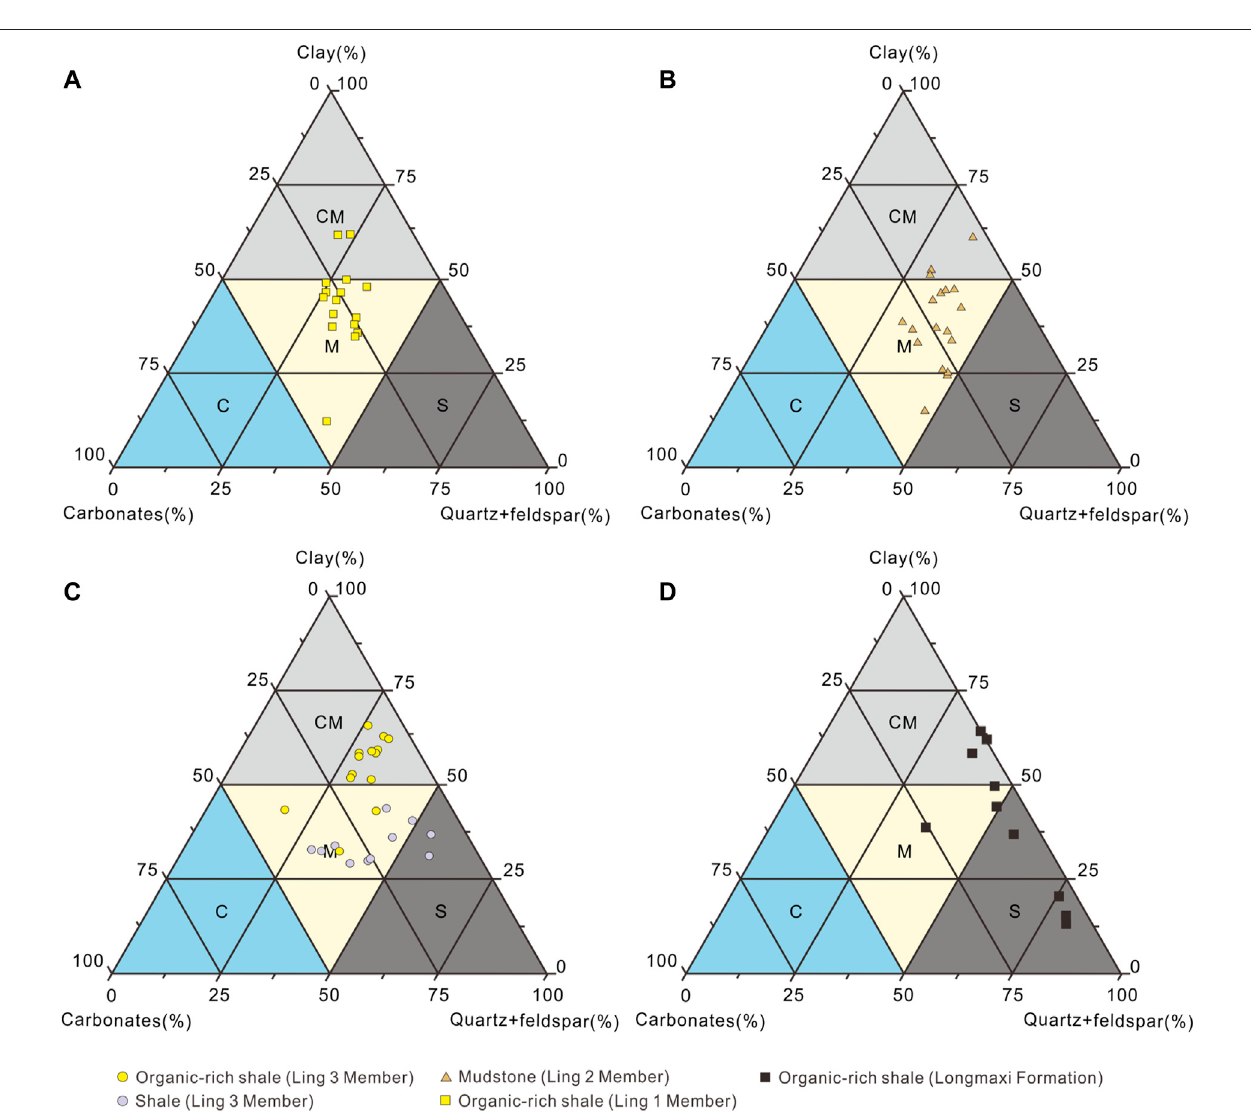
FIGURE 4 | Ternary lithofacies diagram of the Upper Permian Linghao Formation shale/mudstone samples. CM: argillaceous shale; M: mixed shale; S: siliceous shale; C: carbonate shale. (A) Organic-rich shale, Ling 1 member. (B) Mudstone, Ling 2 member. (C) Organic-rich shale and shale, Ling 3 member. (D) Organic-rich marine shale, Longmaxi Formation (Jia et al.,